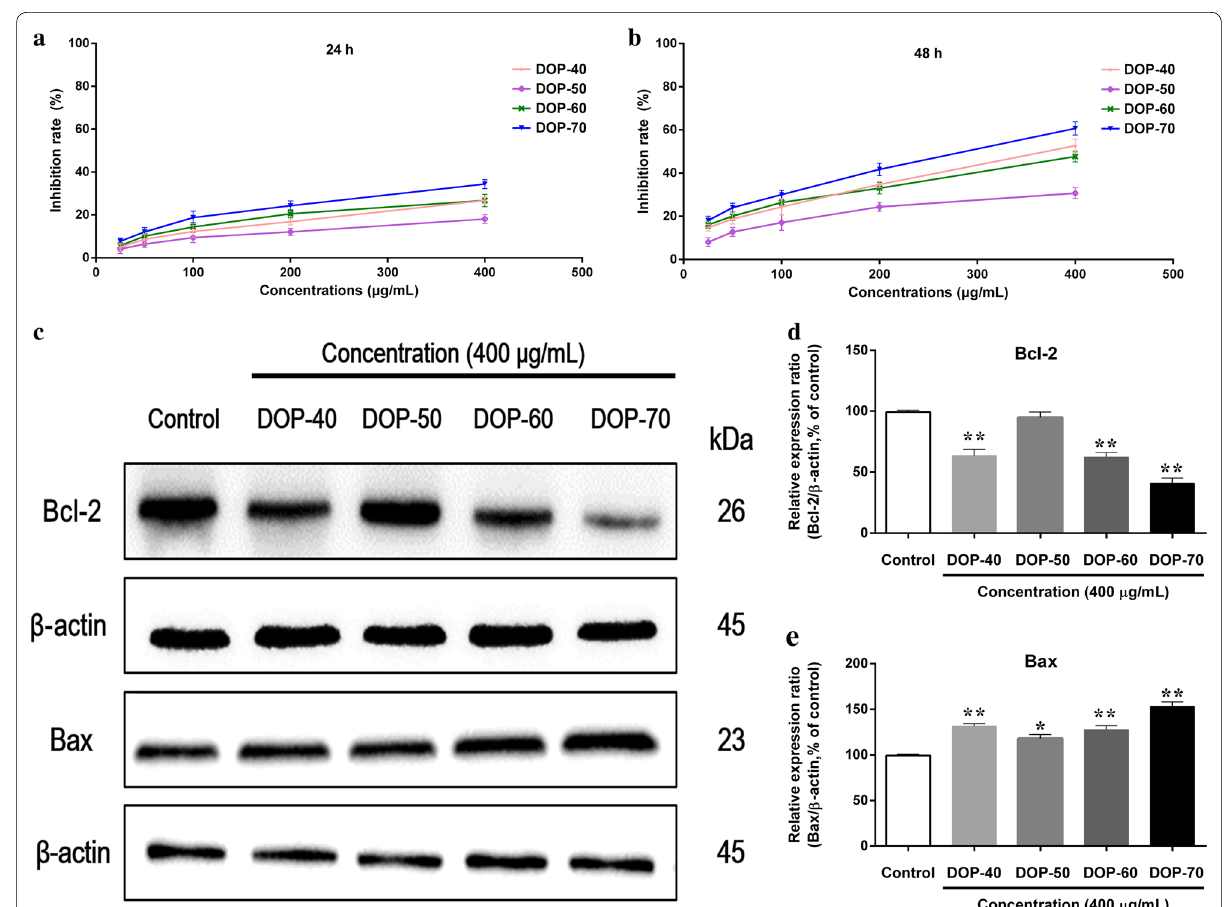
Fig. 6 Growth inhibition analysis of HepG2 cells treated with DOP-40, DOP-50, DOP-60, and DOP-70 for 24 h ( a ) and 48 h ( b ) by MTT assay. The protein levels of Bcl-2 ( c , e ) and Bax ( c , f ) in HepG2 cells treated with DOP-40, DOP-50, DOP-60, and DOP-70 (400 μg/ml) for 48 h were analyzed by western blotting. The bar graphs (mean SD) and representative images are shown. * p < 0.05; ** p < 0.01 compared with the control ±